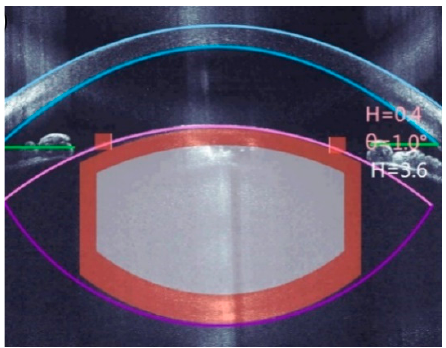
Figure 6. Example of the optical coherence tomography (OCT)-guided placement of an fs-laser cut pattern (blue: corneal anterior and posterior surface; pink and purple: lens anterior and posterior surface; green: iris plane).